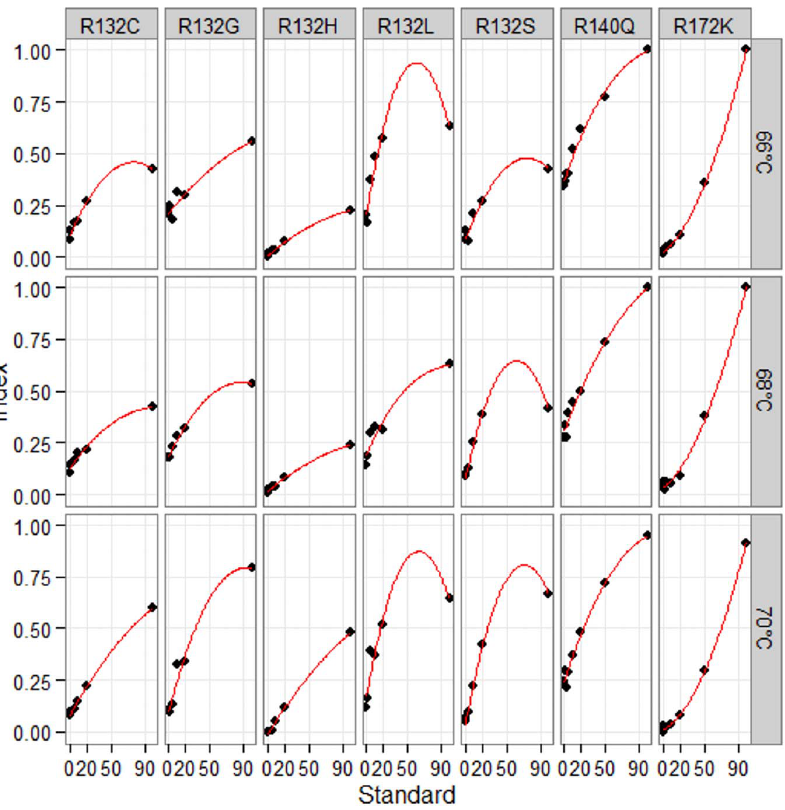
Figure 1. Standard curves for each mutant at the three different hybridization temperatures.